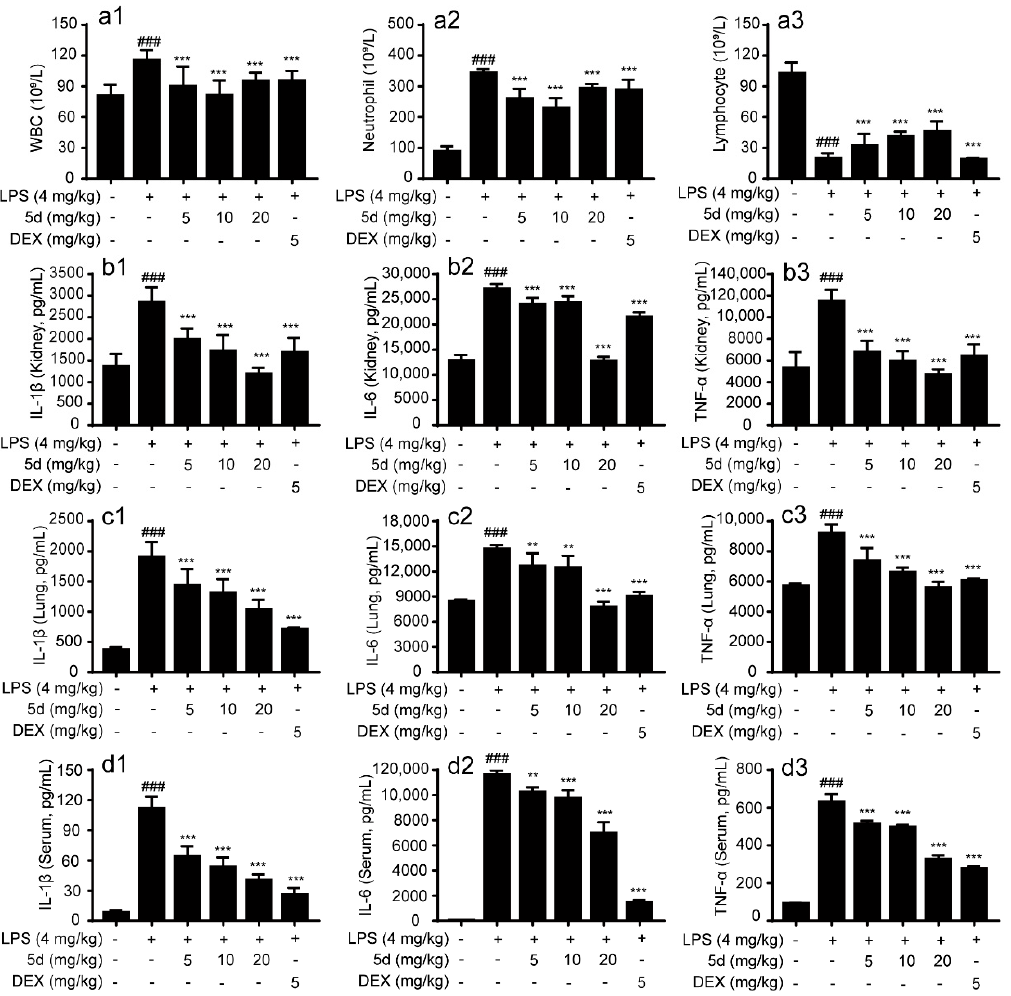
Figure 11. Effects of compound 5d on serum and different tissues of endotoxemic mice. The mice were intraperitoneally injected with LPS (4 mg/kg) or compound 5d (5, 10, 20 mg/kg) at the 5th/10th h. The mice were dissected at the 12th h. The changes of WBC ( a1 ), NEUT ( a2 ), LYM ( a3 ), TNF- α , IL-6 and IL-1 β in serum ( d1 – d3 ) and tissues (Lung: c1 – c3 ; Kidney: b1 – b3 ) were detected. ** p < 0.01, and *** p < 0.001 compared with the LPS group; ### p < 0.001, compared with control group.